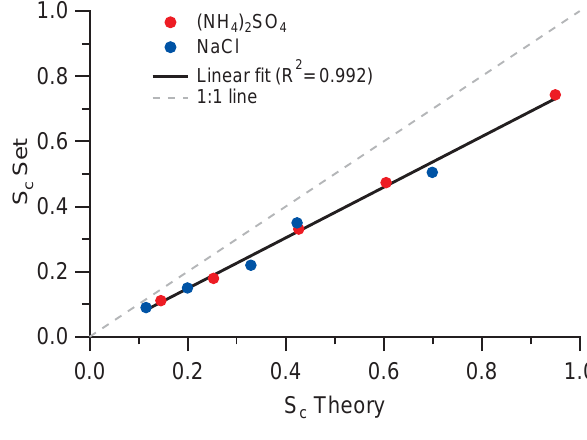
Fig. 4. CCNc ammonium sulphate calibrations. Panels a-e show AF vs. S set for 30, 40, 50, 70 and 100nm D 0 particles made during the MAP campaign. Panel f shows the set point S vs. theory.